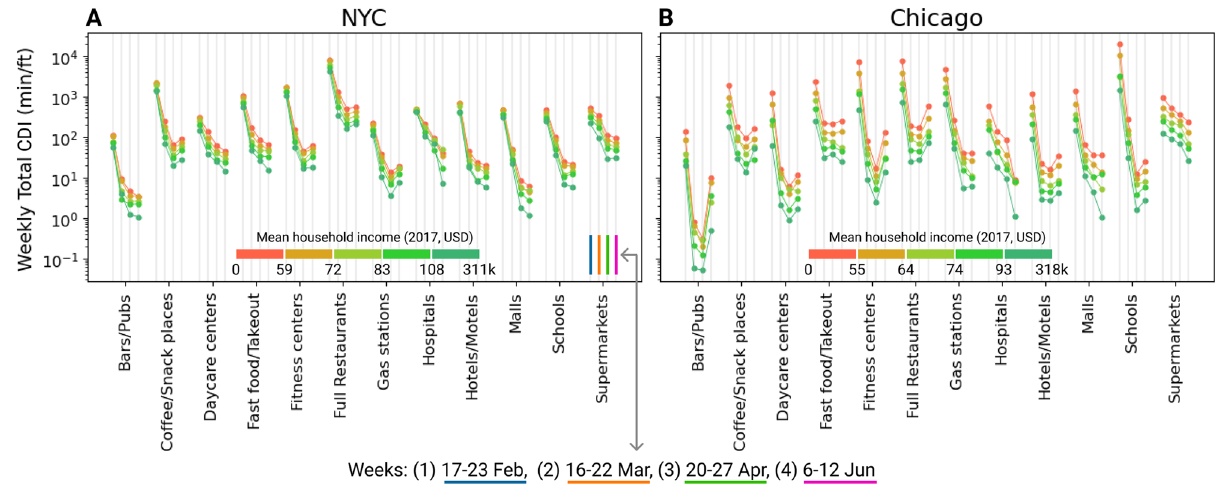
Figure 7. Phase comparison of CDI by industry and income. Variation of CDI generated by residents of neighborhoods of 5 income classes by visiting POIs of the industries of interest in 4 specific weeks representing different phases of the study period in ( A ) NYC and ( B )